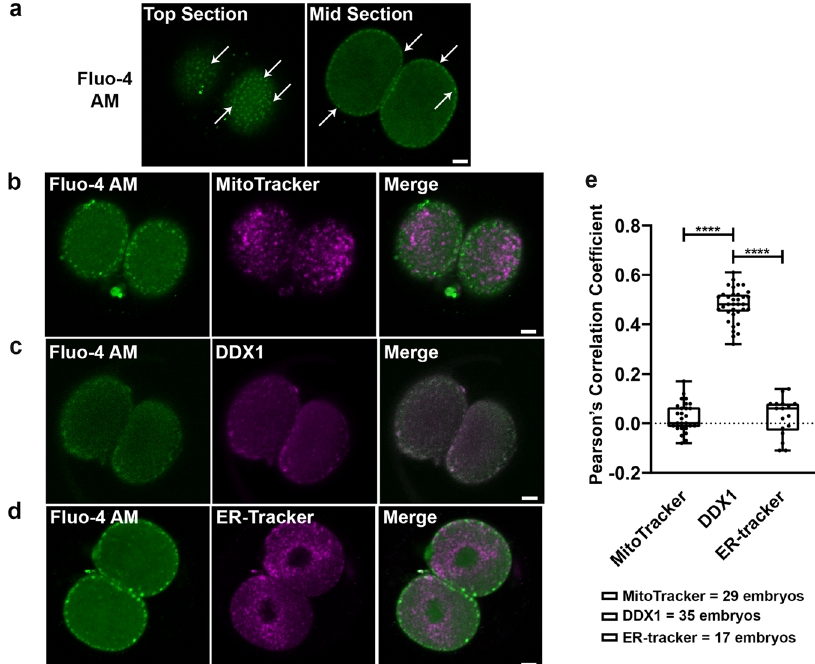
Fig. 2 Co-compartmentalization of Ca 2 + and DDX1 in MARVs but not ER or mitochondria. a Ca 2 + microdomains in 2-cell embryos show a similar distribution to that of DDX1. Arrows point to a subset of Ca 2 + microdomains. b Ca 2 + microdomains (Fluo-4 AM, green) do not co-compartmentalize with MitoTracker Deep Red (magenta). c Ca 2 + microdomains (Fluo-4 AM, green) co-compartmentalizes with DDX1 (magenta) in 2-cell embryos. d Ca 2 + microdomains (Fluo-4 AM, green) do not co-compartmentalize with ER-Tracker Red (magenta). e Statistical analysis of ( b ) Fluo-4 AM/Mitotracker, ( c ) Fluo-4 AM/DDX1 and ( d ) Fluo-4 AM/ER-Tracker, with 2-cell embryos obtained from 3, 4 and 2 pairs, respectively, of wild-type natural matings. Pearson ’ s correlation coef fi cients were calculated by ImageJ and plotted with Prism. Statistical analysis of single plane confocal images of each embryo (middle sections) was performed with one-way ANOVA and Tukey multiple comparison test. ****indicates p < 0.0001. Center line, median; box limits, 25th and 75th percentiles; whiskers, minimum to maximum. Error bars represent standard deviation. Scale bars = 10 µ